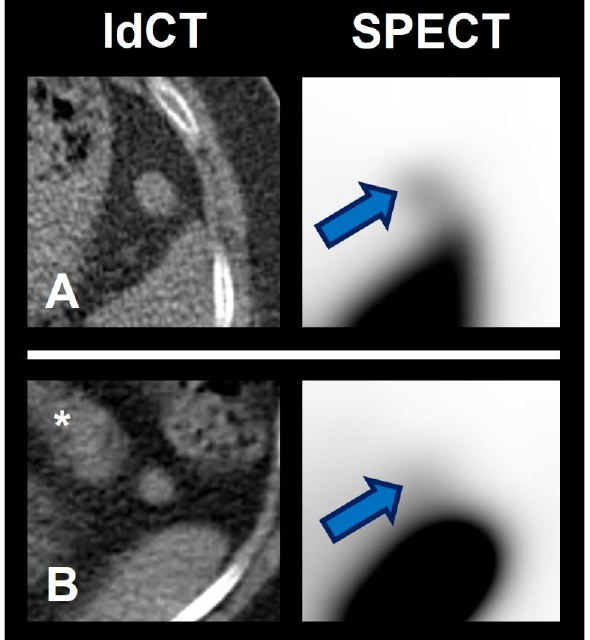
Figure 7. Example of two challenging cases in spleen scintigraphy reading. ( Left ) low dose CT. ( Right ) 99m Tc-labelled denatured red blood cells SPECT. ( A ) = Rated as spleen tissue using the quantitative cutoff. Clinical follow up showed no evidence of a progression of the perisplenic lesion. ( B ) = Not rated as spleen tissue using the quantitative cutoff. Endosonographic biopsy was performed and confirmed the rating. Arrows = lesional uptake. Asterisk = pancreas.